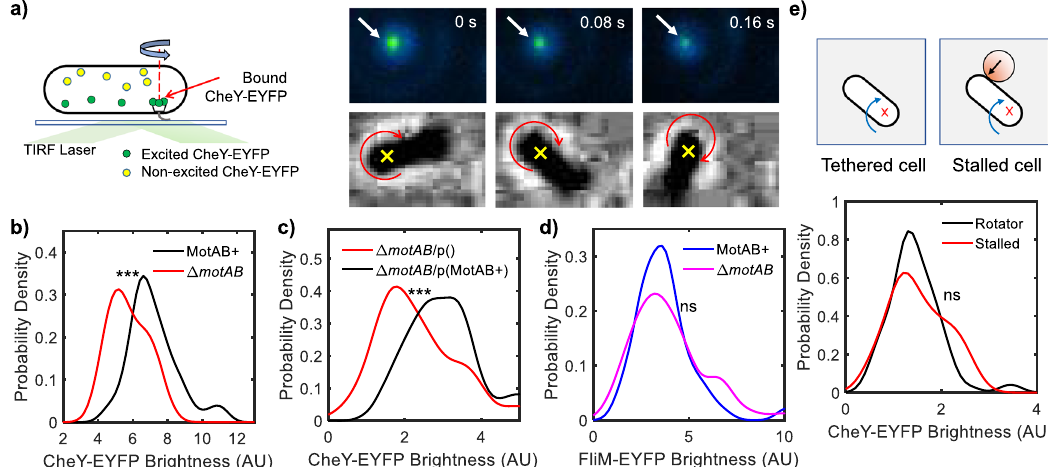
Fig. 1 Binding of CheY-P to the motor increases with the number of bound stator units. a We monitored the rotation of tethered cells simultaneously in the TIRF and phase channels. The fl uorescent moieties (CheY-EYFP) were visible in the evanescent fi eld as they bound to the motor: The top row shows a time series of TIRF images for a single tethered cell. The arrow points to CheY-P bound to the motor. The corresponding phase contrast images are shown in the bottom row. The ⨯ shows the point of tethering around which the cell rotates. b The intensity of CheY-P localized around each motor was quantitatively estimated from the TIRF images (see Methods ). The probability-density estimates are indicated for a strain carrying functional stators (MotAB + strain, black curve, n = 50 independent motors) and a strain lacking stator proteins ( Δ motAB strain, red curve, n = 48 independent motors). The difference in the mean intensities in the two strains was signi fi cant (*** p -value = 1.3 × 10 − 7 , <0.001). The mean number of CheY-P molecules bound to the motor in the absence of stator units was lower than that in the presence of stators units. c We compared CheY-EYFP binding to the motors in the Δ motAB strain transformed with a plasmid encoding MotA and MotB with that in a Δ motAB strain transformed with an empty plasmid. The strain lacking MotA- MotB (red curve, n = 108 independent motors) had signi fi cantly lower intensities (*** p -value = 1.7 × 10 − 5 , <0.001) than the strain expressing MotA-MotB (black curve, n = 46 independent motors). d We measured the localization of FliM-EYFP-FliM in each tethered cell. The difference in the mean intensities in the motors of a strain carrying functional stators (blue curve, n = 75 independent motors) and a strain lacking stator proteins (magenta curve, n = 115 independent motors) was not statistically signi fi cant (ns, p -value > 0.05). e Tethered cells were stalled by obstructing the rotation with optically trapped beads. The difference in the mean CheY-EYFP intensities in rotating cells (black curve, n = 86 independent motors) and stalled cells (red curve, n = 36 independent motors) was not statistically signi fi cant (ns, p -value > 0.05). Source data are provided as a Source Data fi